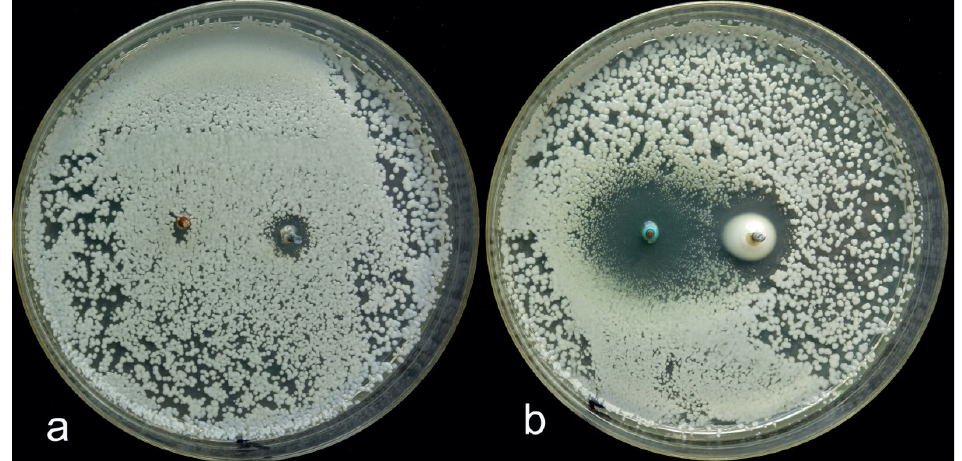
Figure 4. Influence of NaCl on the size of the inhibition zone for Aureobasidium pullulans : ( a )—control, ( b )—3% NaCl, distance between electrodes of Zn and Cu—5 mm, photo A. Chlebicki.